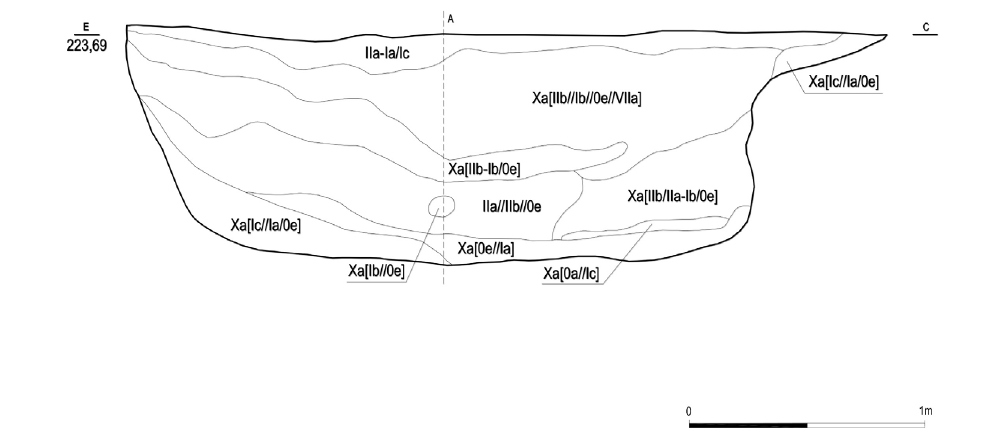
Figure 5: Cross-section of feature 419, site Targowisko 14–15.